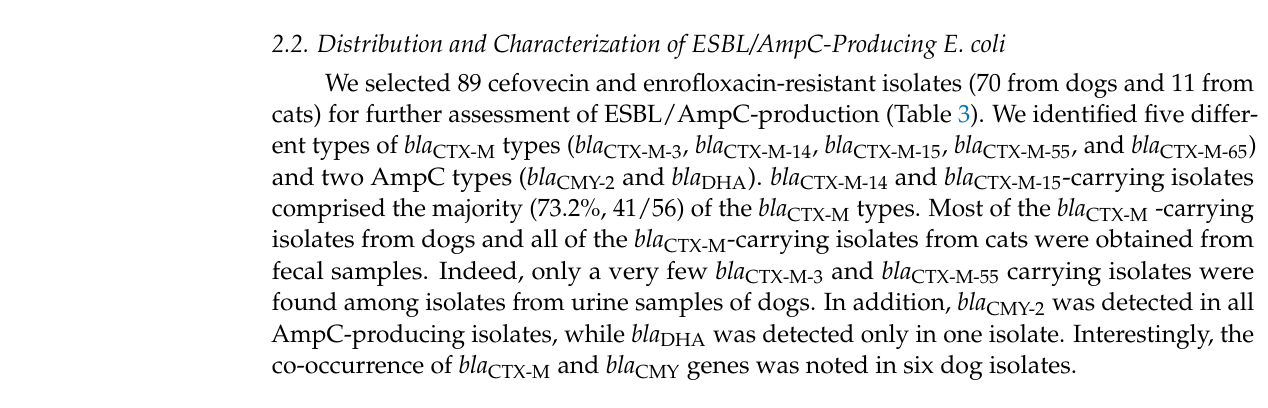
Table 3. Distribution of ESBL/AmpC-producing E. coli isolated from diseased dogs and